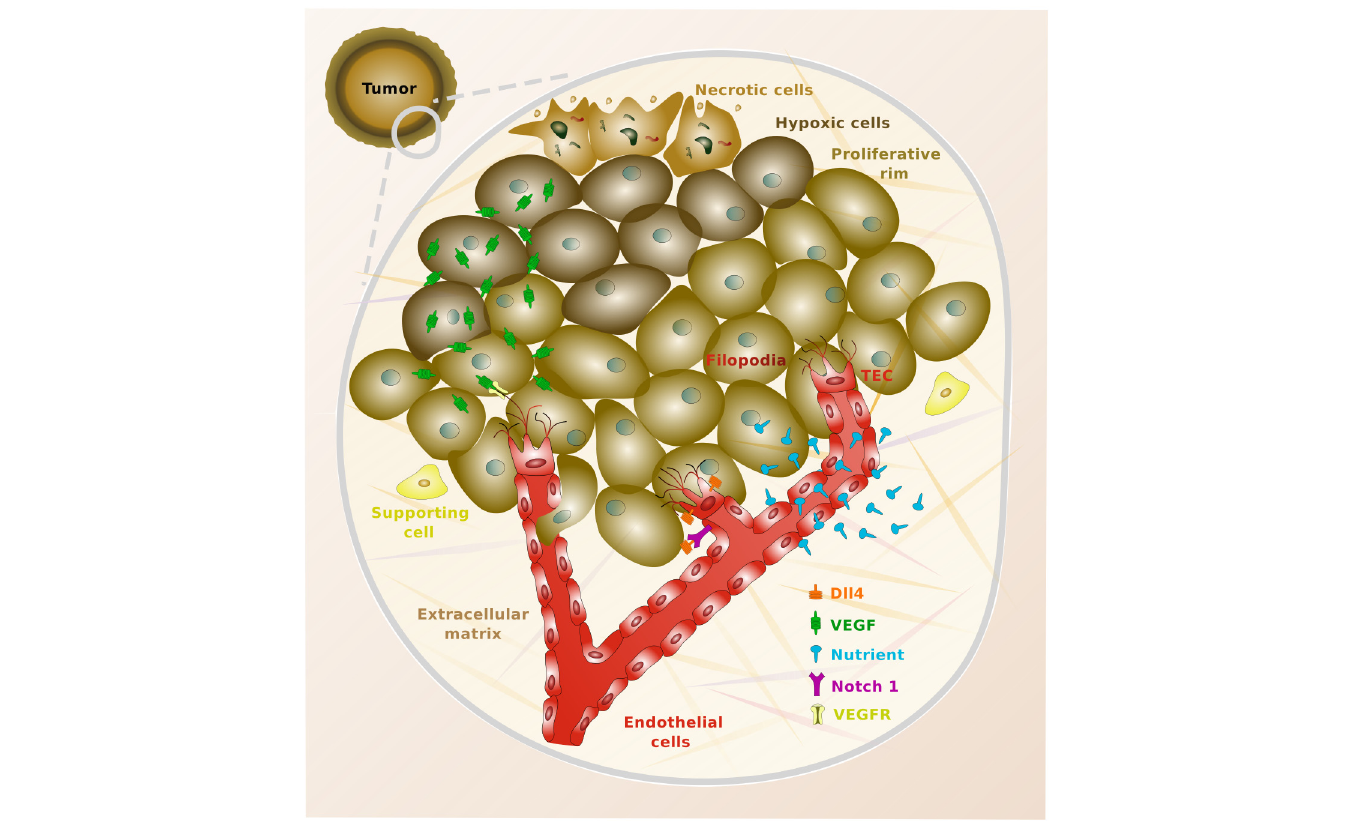
Fig 1. Vascular tumor growth. The top left part represents a relatively small tumor which is undergoing the vascular switch. The tumor is radially divided into three parts, which represent the proliferative rim (outer ring), the hypoxic zone (mid part), and the necrotic core (inner area). A small area of the tumor is surrounded by a gray solid line whose interior is zoomed in. In the zoomed-in area, we can observe tumoral cells colored with different brown tones, according to their condition of necrotic, hypoxic, or proliferative cells. The red area shows the capillaries, which are lined by endothelial cells as shown in the plot. The new sprouts are led by tip endothelial cells (TECs), which are endowed with filopodia to better explore their surroundings [10, 15]. The picture also shows how the capillaries release nutrients that diffuse throughout the tissue. Similarly, hypoxic cells release vascular endothelial growth factor (VEGF), which eventually binds to surface receptors located in the membrane of endothelial cells (VEGFR). Finally, the figure shows how TECs overexpress the protein Delta-like ligand 4 (Dll4). This protein binds to the Notch receptors of nearby endothelial cells, preventing them from also becoming TECs [12,